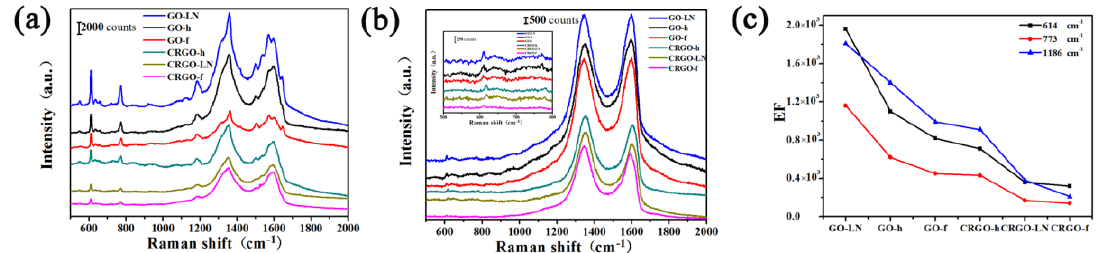
Figure 4. Raman spectra of R6G deposited on different films by soaking in ( a ) 1 × 10 −6 M and ( b ) 1 × 10 −7 M R6G solution; ( c ) Enhancement factors (EFs) for the main vibration modes of R6G (1 × 10 −6 M) on different films.